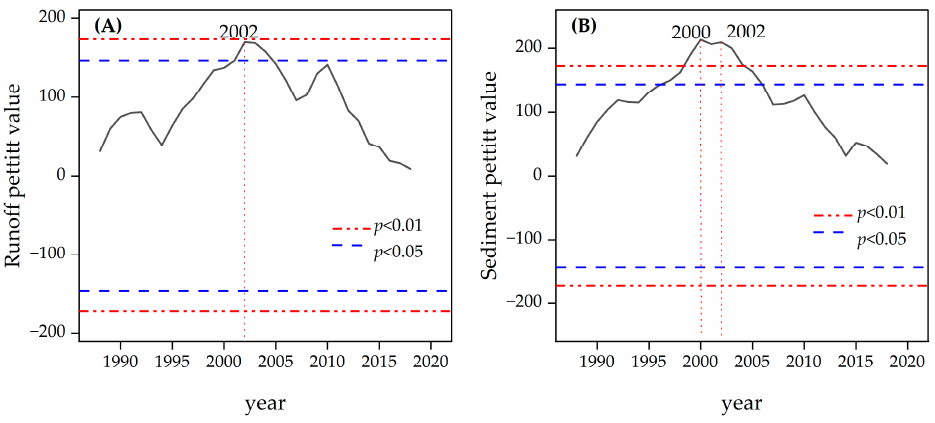
Figure 2. Pettit detection trends of runoff and sediment yield: ( A ), Runoff time series. ( B ), Sediment time series.